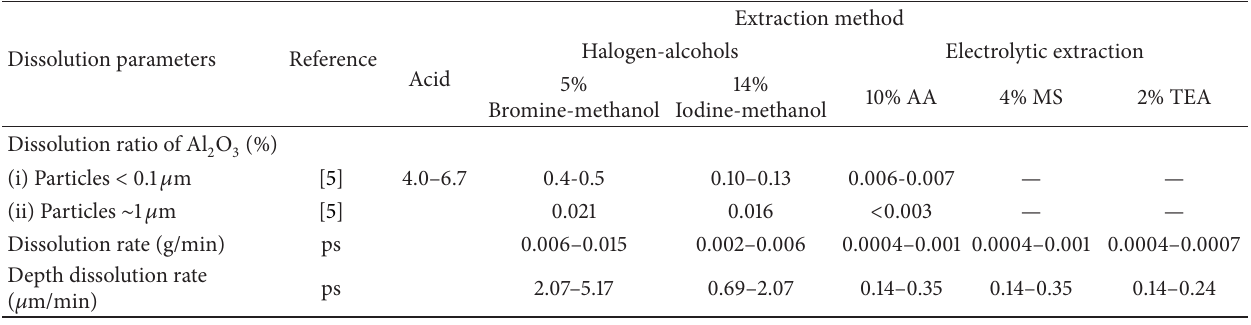
Table 1: Comparison of main parameters of different extraction methods for investigation of nonmetallic inclusions in metal sample.